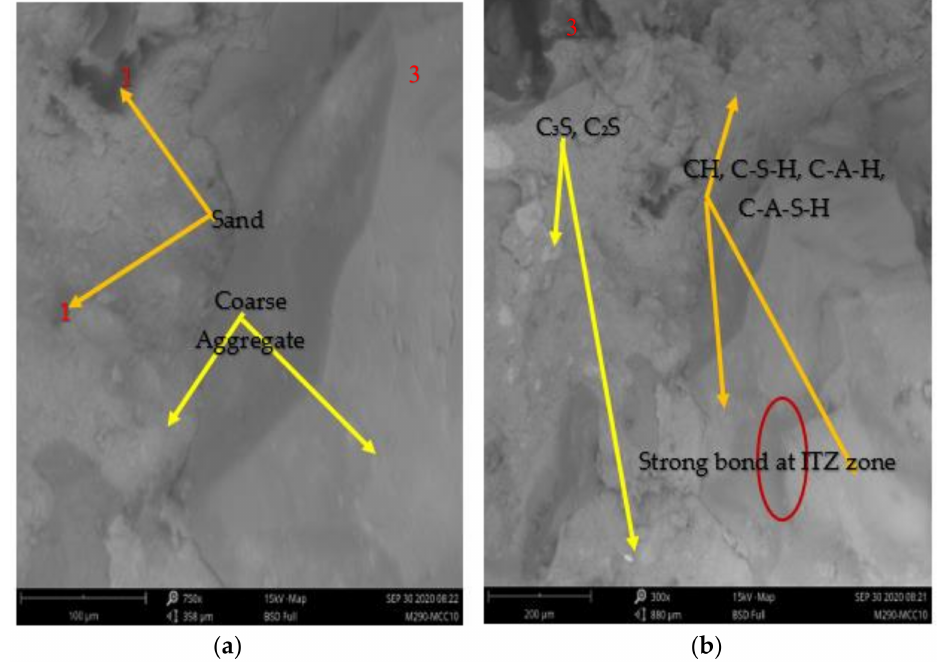
Figure 14. ( a , b ) SEM images of MCCC-10 HPC at 90